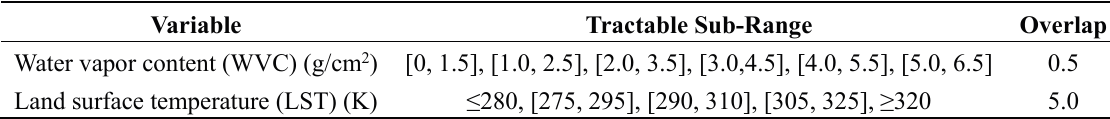
Figure 5. Histograms of the difference between the actual (cid:1846) Equation (2) for ( a ) the WVC sub-range [0, 1.5] and VZA = 0° and ( b ) the WVC sub-range [5.5, 6.5] and VZA = 60°. Table 2. Tractable sub-ranges of WVC and LST to determine the regression coefficients in Equation